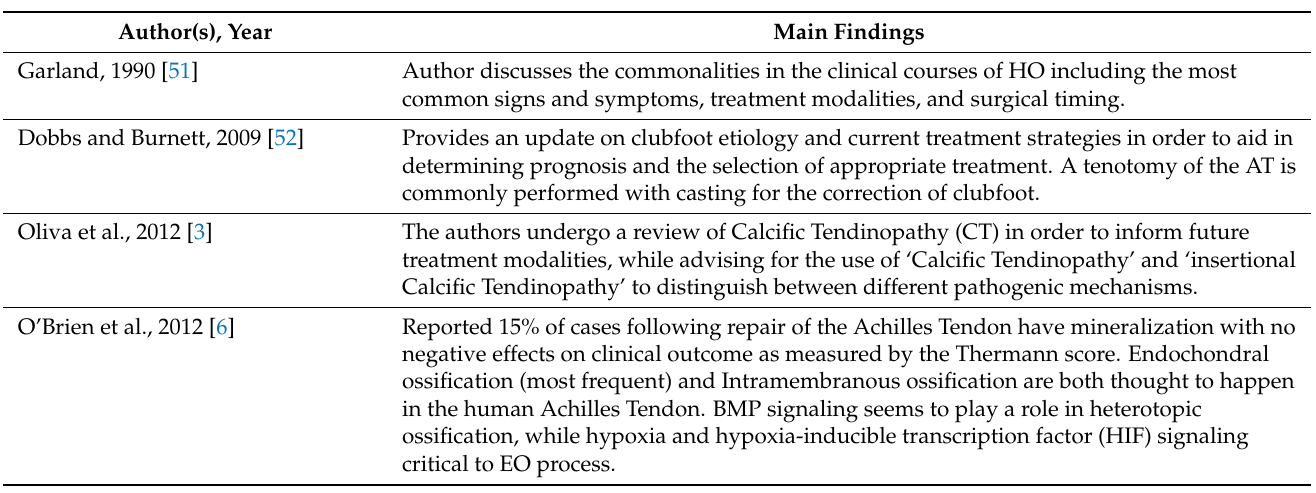
Table 7. Relevant articles (Reviews; 1990–2020) and their main